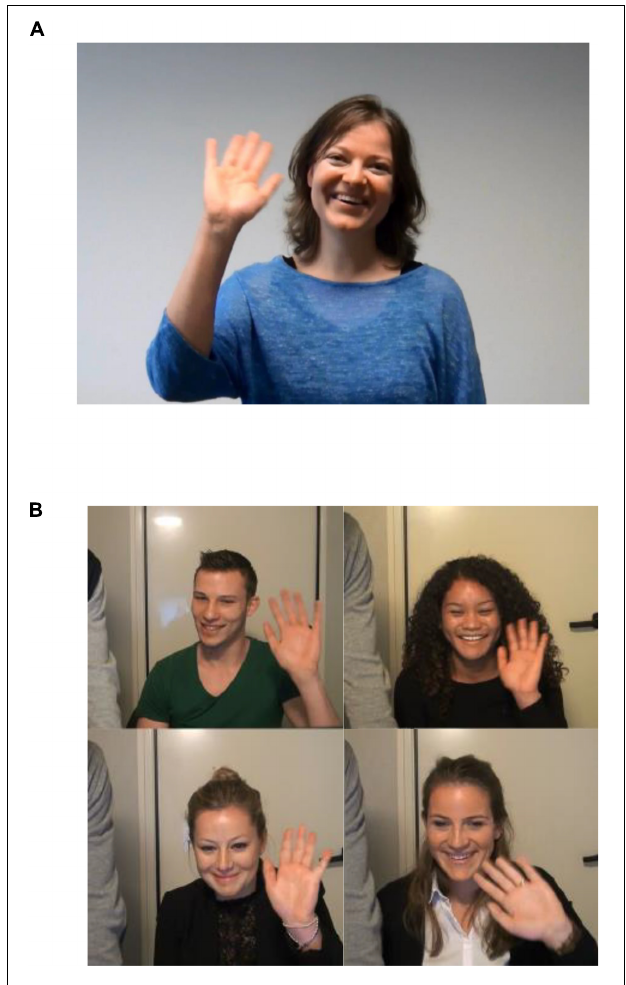
FIGURE 2 | (A) Still of the interaction partner greeting the participant, and (B) example stills of participants waving back. Written consent was obtained for the publication of their identifiable images.